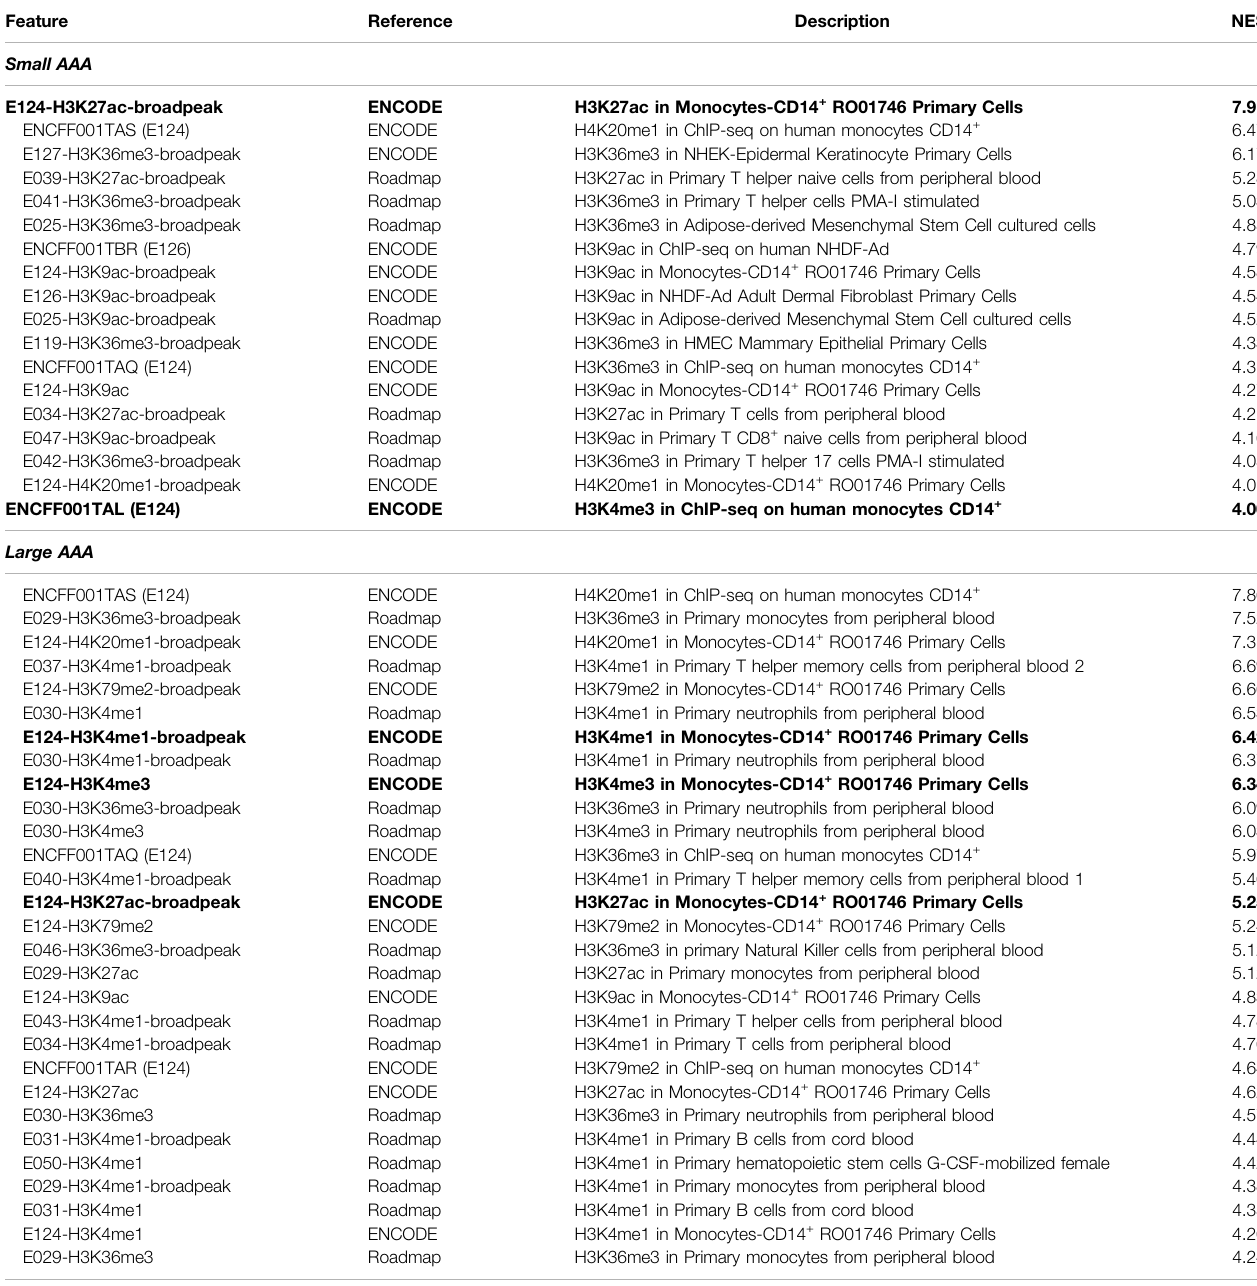
TABLE 1 | Predicted histone modi fi cations associated with overexpressed genes in perivascular adipose tissue of small and large abdominal aortic